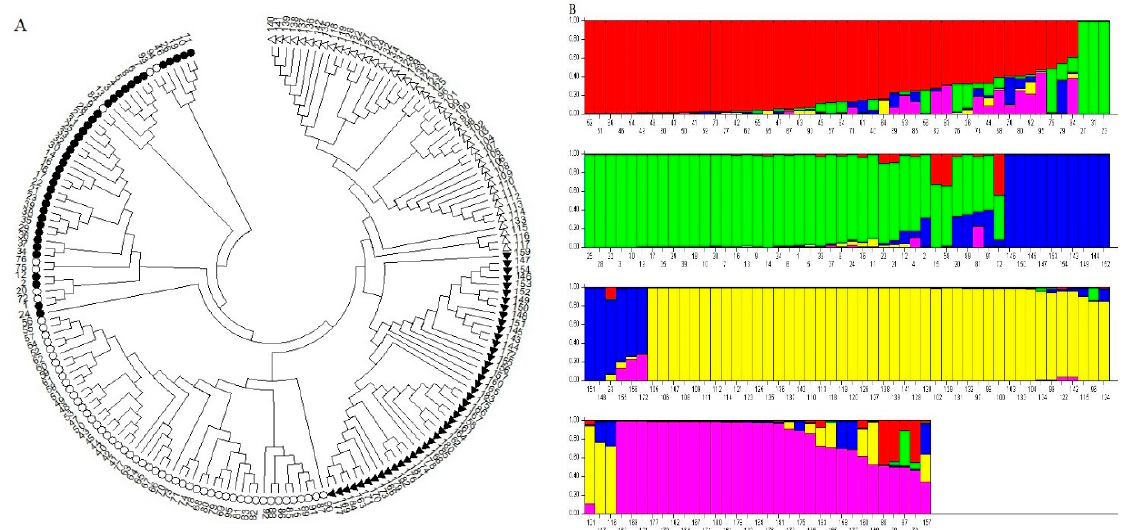
Figure 4. (A) The Fan-dendrogram obtained using SSR markers shows the phylogenetic relationships among the investigated wheat accessions. Empty circles, filled circles, empty triangles, and filled triangles indicate Ae. tauschii , T. aestivum , Ae. cylindrica , and Ae. crassa , respectively. ( B ) STRUCTURE analysis of the investigated accessions. Bars represent the membership coefficients of samples based on allele frequencies for